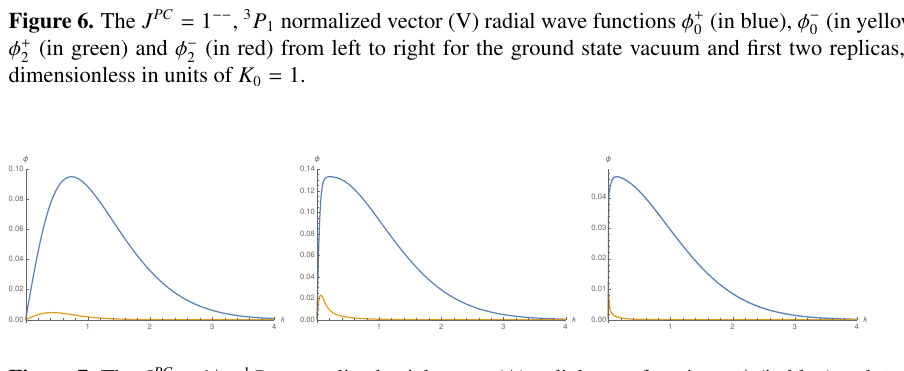
Figure 7. The J PC = 1 + − , 1 P 1 normalized axial vector (A) radial wave functions φ + (in blue) and φ − (in yellow), from left to right for the ground state vacuum and first two replicas, in dimensionless in units of K 0 =